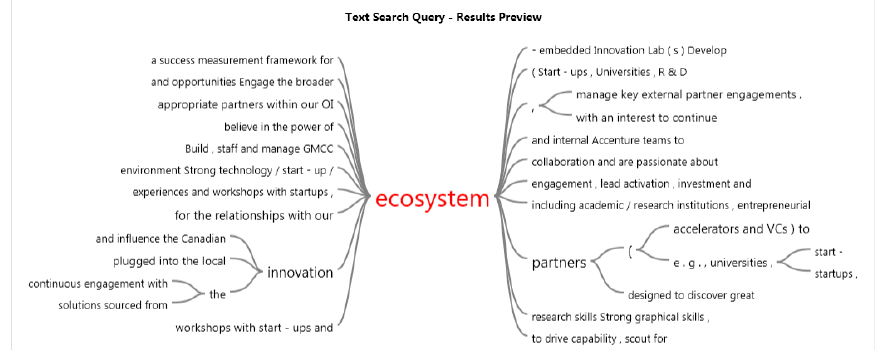
Fig. 5. Word tree for pattern in words: network, partners, ecosystem in 23 job descriptions with open innovation in the title.